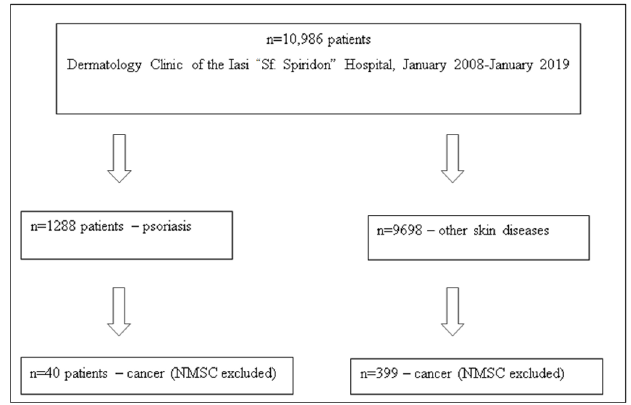
Figure 1. Patients associating the diagnosis of psoriasis with various types of cancer at the Derma- tology Clinic of the Iasi “Sf. Spiridon” Emergency Hospital in the interval January 2008–January 2019.